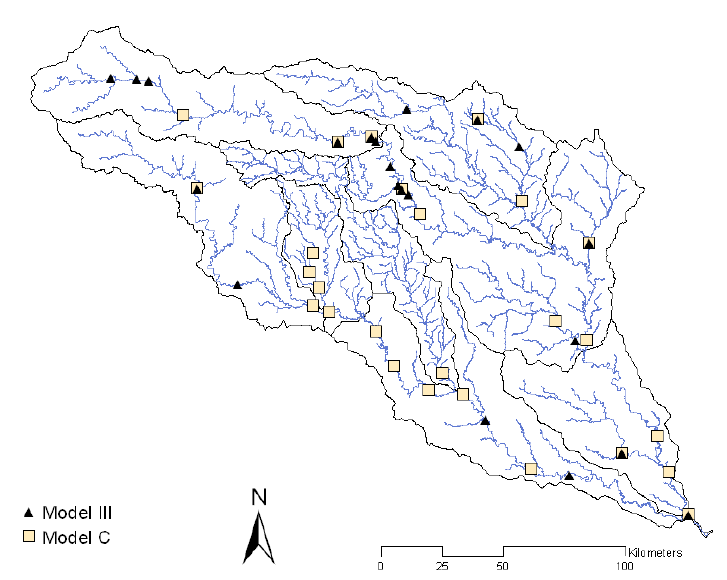
Figure 4. Monitoring stations selected in Model C and Model III.